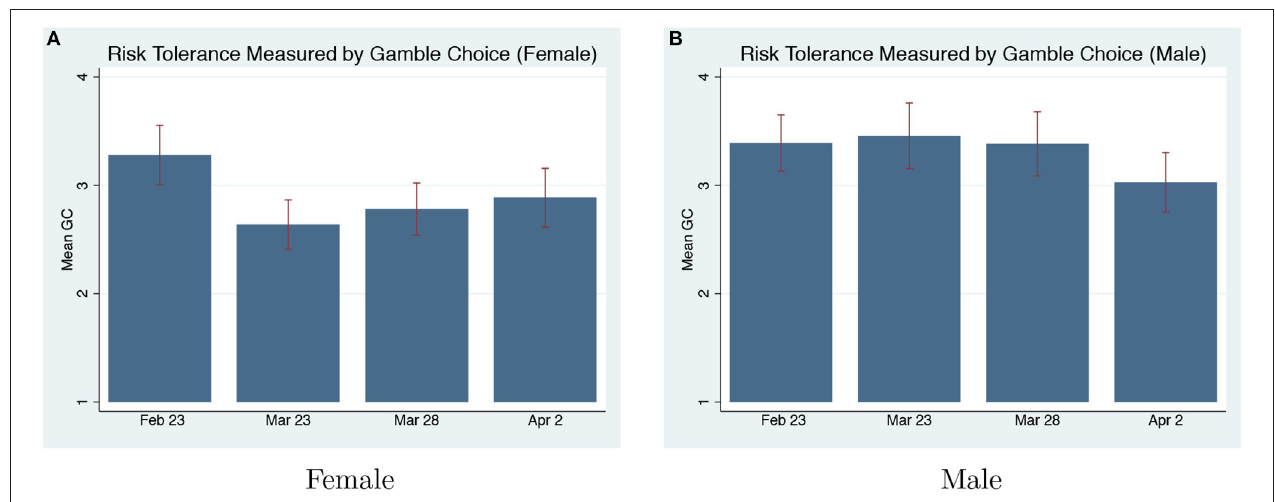
FIGURE 3 | GC pre and on-pandemic. (A) Risk tolerance measured by gamble choice (Female). (B) Risk tolerance measured by gamble choice